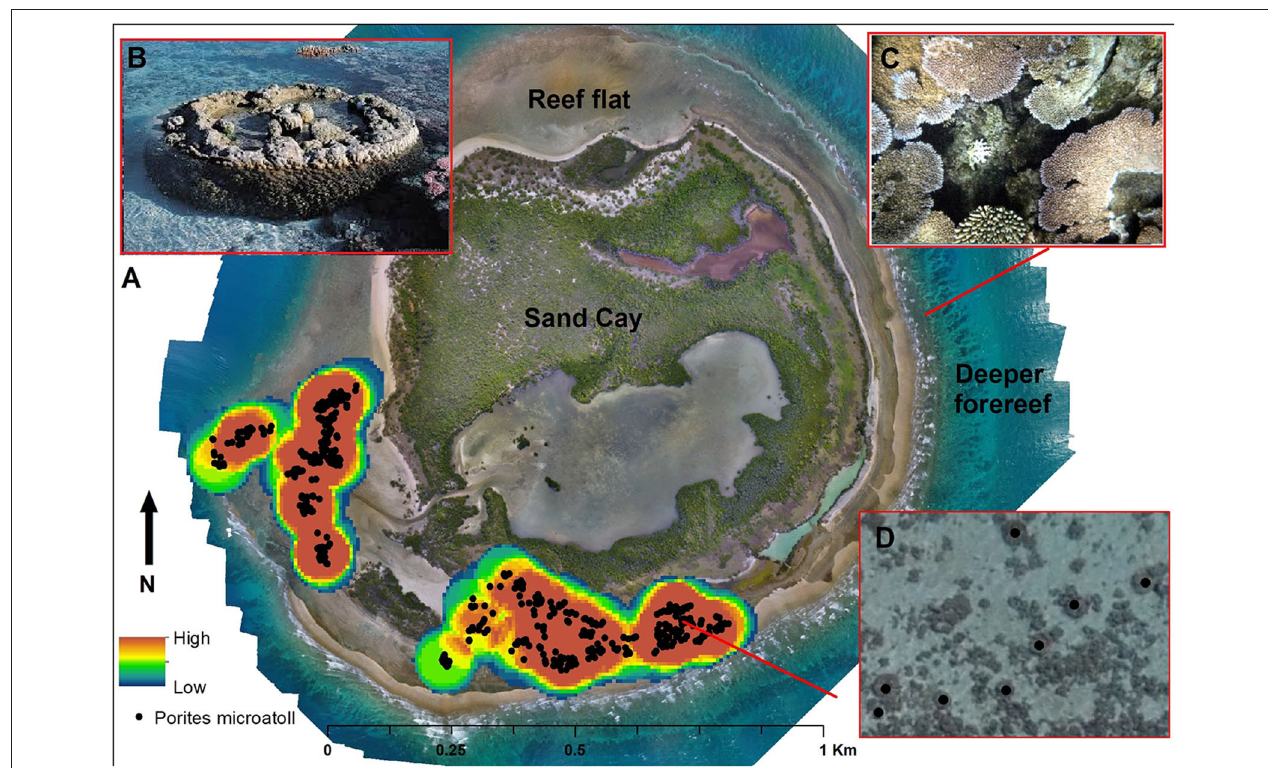
FIGURE 1 | (A) A mosaic of 1400 UAV images over Nymph Island, GBR, including a map to indicate probability of microatoll detection based on intertidal areas and density of reef flat coral framework. (B) A porites microatoll coral on the reef flat. (C) The detail visible in an aerial drone image of a reef flat, showing individual corals. (D) Porites microatolls detected on the reef